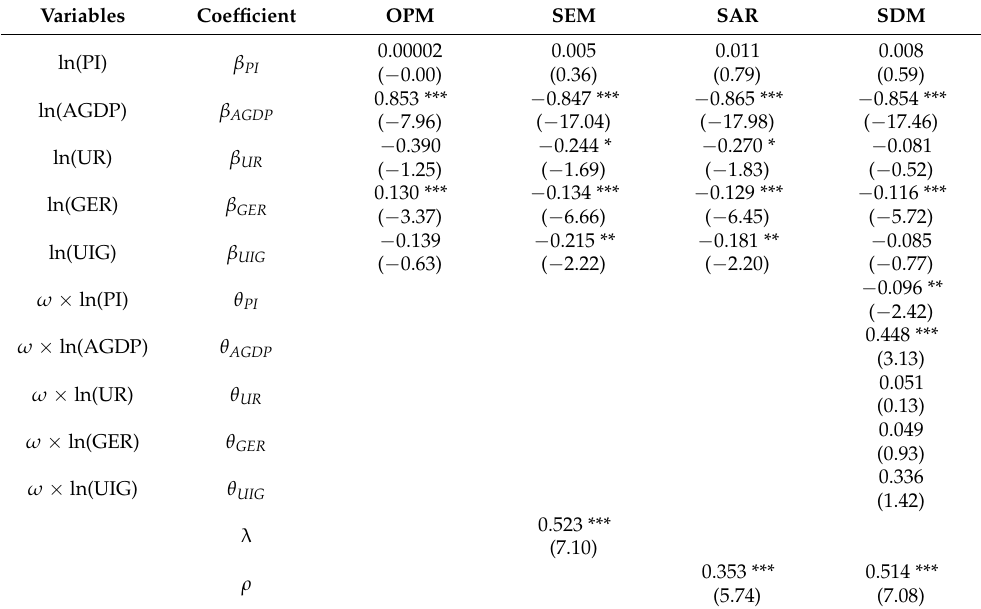
Table 5. Estimation results of the OPM, SEM, SAR, and SDM.